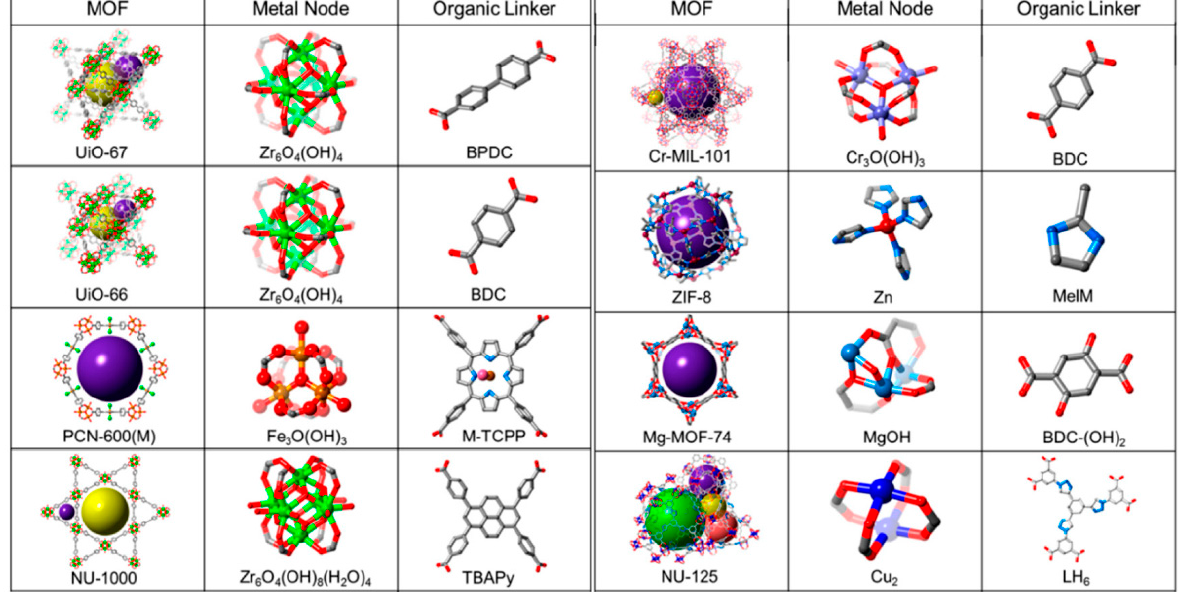
Figure 1. Different MOFs and the organic linkers [11] ( copyright 2020 MDPI). Mn, Cu, Fe, and Ni-based MOFs are the most common monometallic MOFs used for NO x SCR (Figure 1). Manganese oxide is a traditional SCR catalyst with good low- temperature NO x SCR activity. Jiang et al. reported a hollow spherical Mn-MOF-74